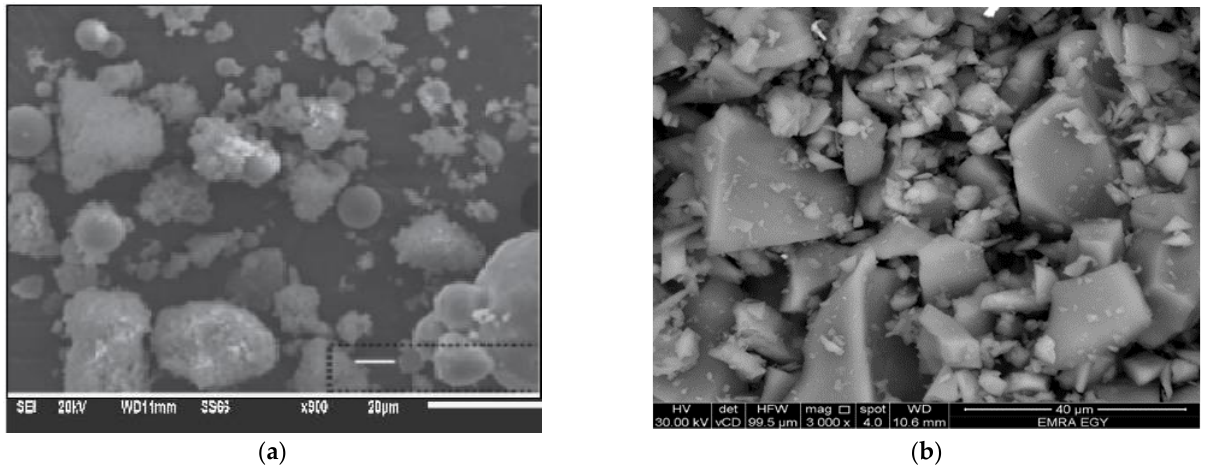
Figure 3. Photomicrographs of Lime and Glass powder under SEM. ( a ) Lime powder. ( b ) Glass powder.